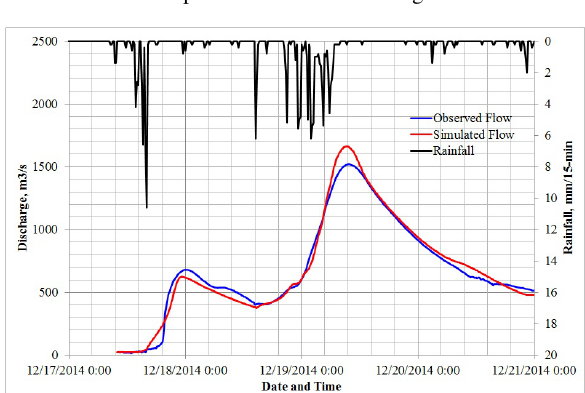
Figure 5: Result of calibrating the Tago HEC HMS model using the measured flow data at Cabtik